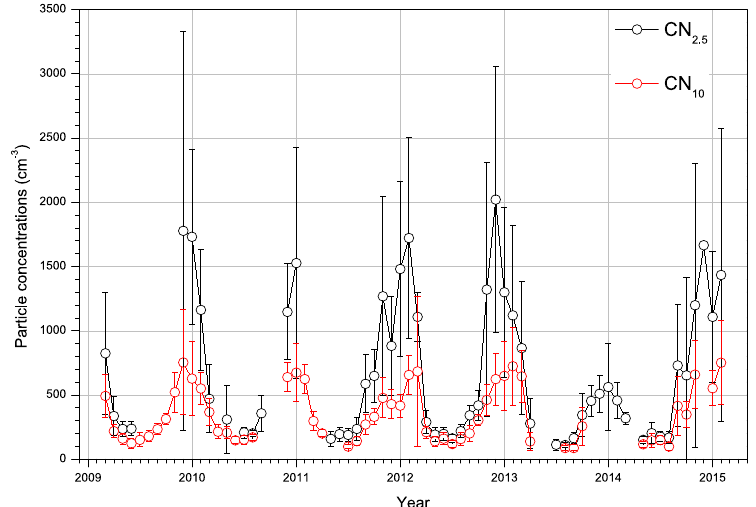
Figure 4. Monthly variations of mean CN 2 . 5 (black open circle) and CN 10 (red open circle) concentrations with a standard deviation from March 2009 to February 2015. The error bars represent the standard deviation of the measurements from the mean